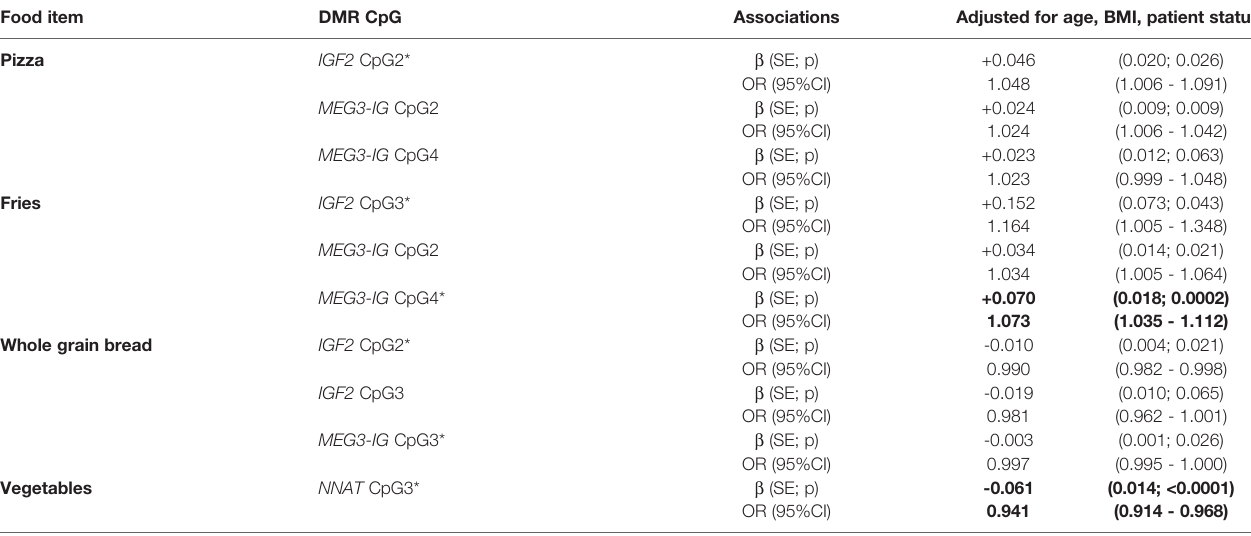
TABLE 5 | Associations between diet and DNA methylation levels at CpG sites of imprinted genes. Food item DMR CpG